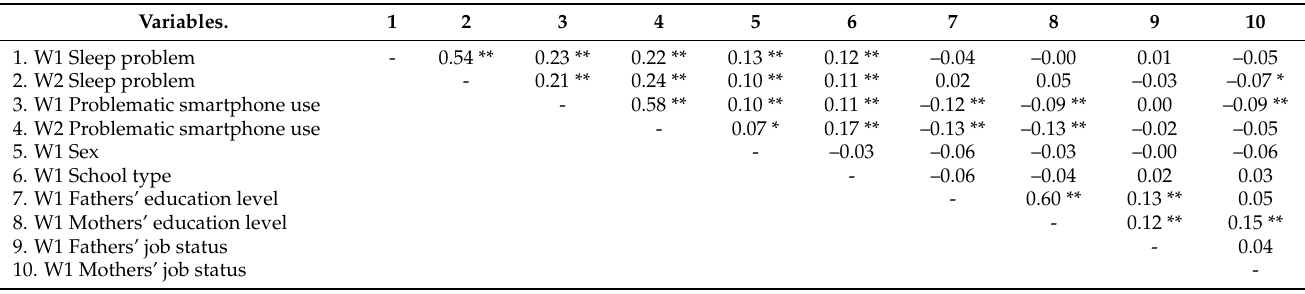
Table 2. Correlations among all study